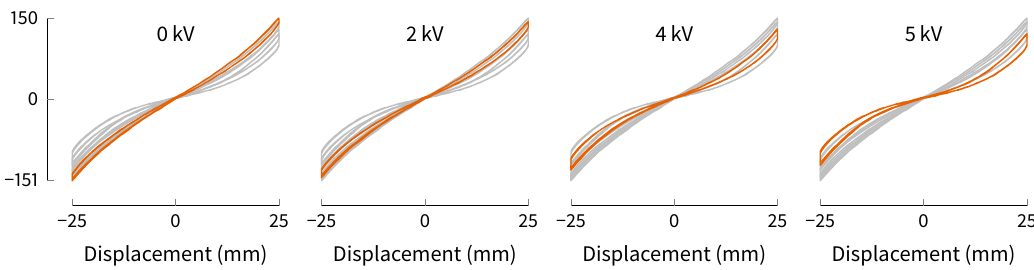
Figure 6. The VSA’s variable stiffness mechanism softens when charged with a constant voltage, as seen in these tensile test results with a displacement rate of 1mm/s. The loops progress in a clockwise direction. The light gray curves are data from the other voltage levels given for context.